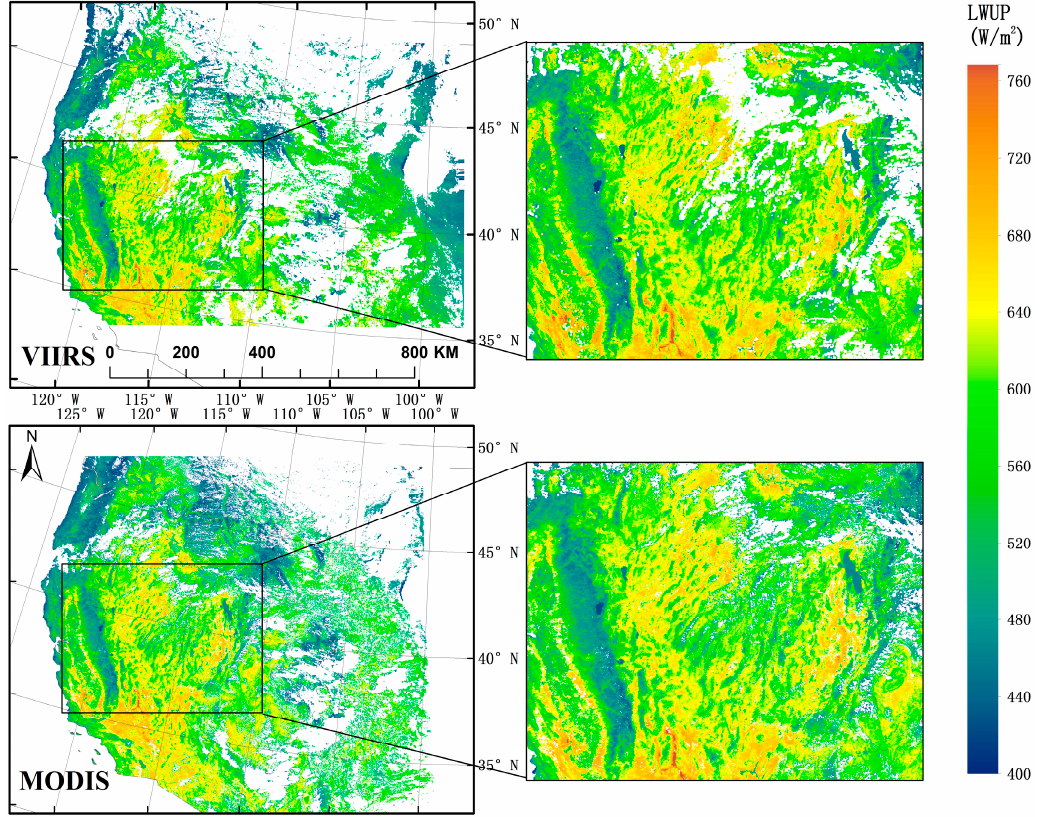
Figure 5. Distribution of LWUPs derived from VIIRS and MODIS images.